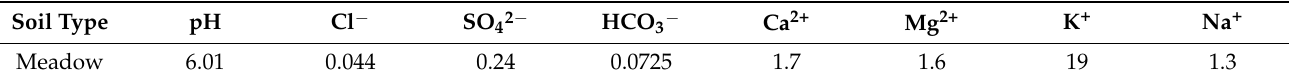
Table 1. Chemical composition of the dry soil taken from